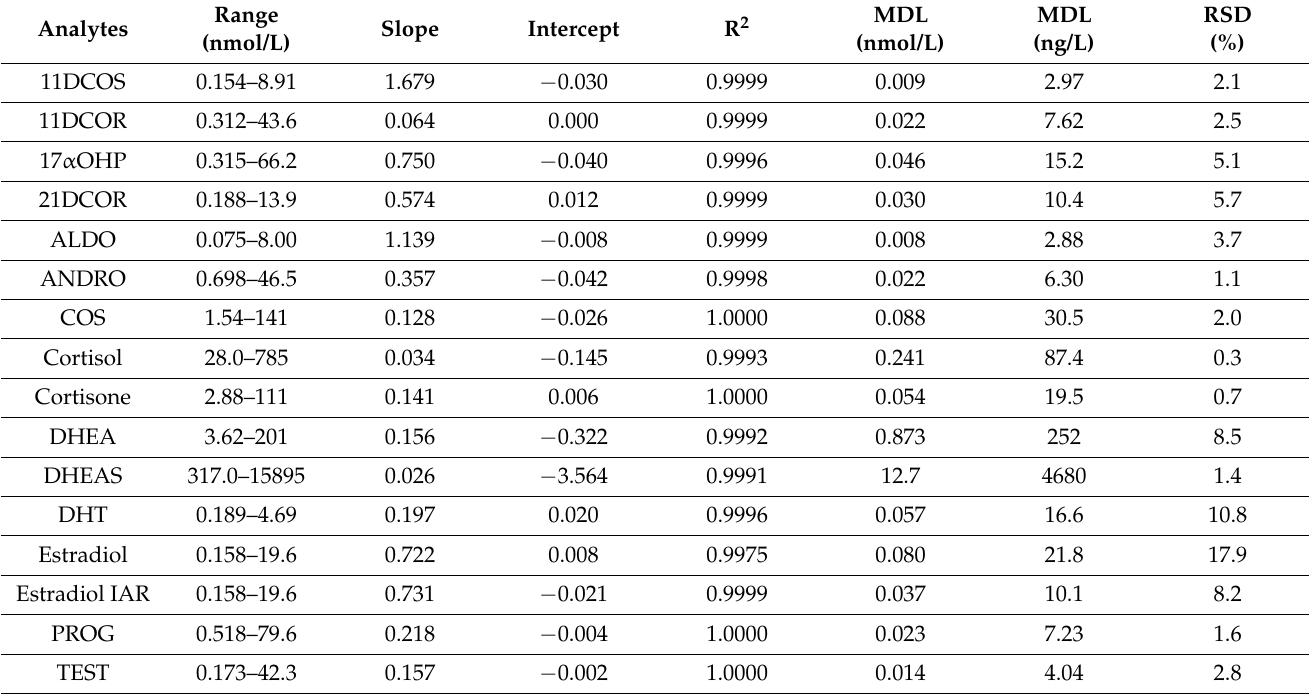
Table 5. Linearity and MDL for all steroid